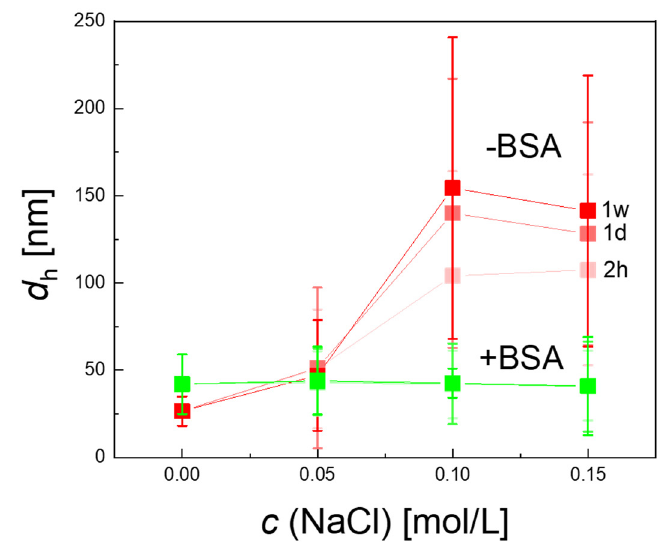
Figure 6. Colloidal stability of MNP. The hydrodynamic diameter as function of saline concentration ( c (NaCl) = 0.05, 0.10, 0.15 Mol/L) measured by DCS 2 h (2 h), 1 day (1 d), and 1 week (1 w) after incubation. Notably, for BSA-coated MNP (green symbols), all three curves coincide within symbol thickness, proving that the hydrodynamic diameters d h of BSA-coated MNP remain unchanged (<1%). For BSA-coated MNP (red symbols), d h is already significantly increased at the lowest saline concentration. The full-width-at-half-maximum (FWHM) of the size distribution is displayed as uncertainty bars. The lines between the symbols are reading aids.